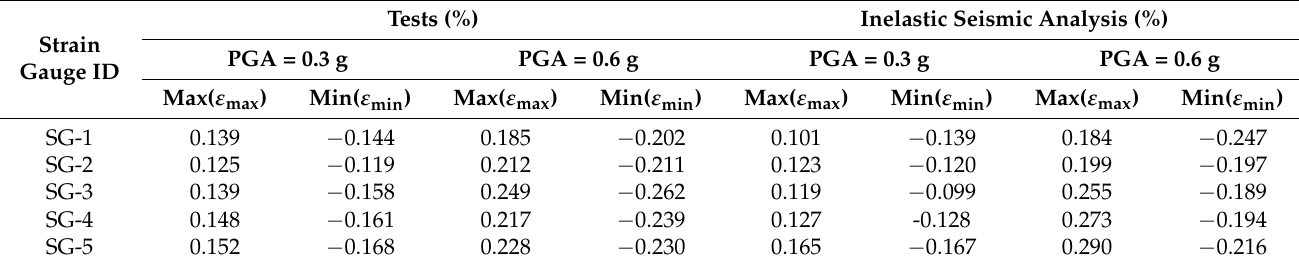
Table 10. Comparison results of principal strain